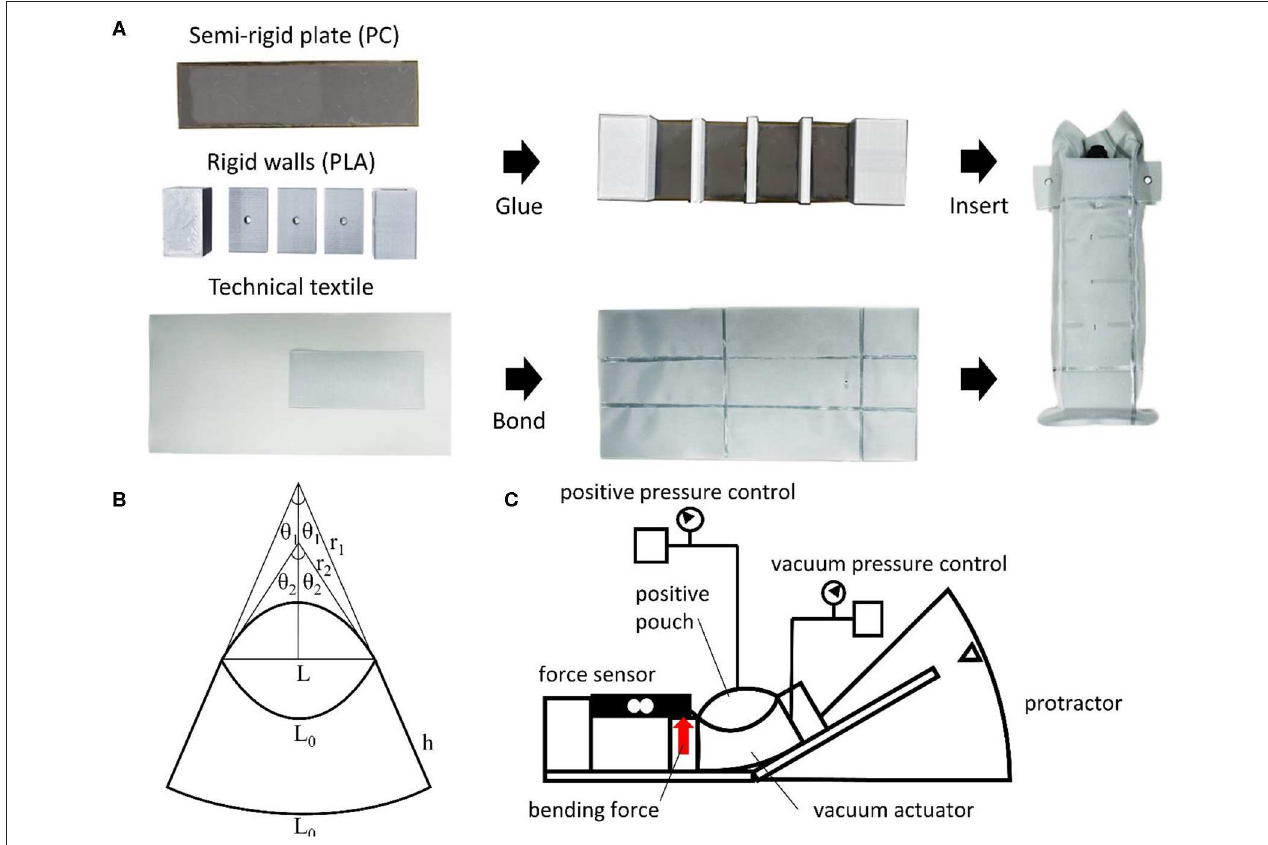
FIGURE 2 | (A) Assembly process of the actuator, (B) dimensions of the actuator used for modeling, and (C) testing jig for measuring the bending force at different bending angles.